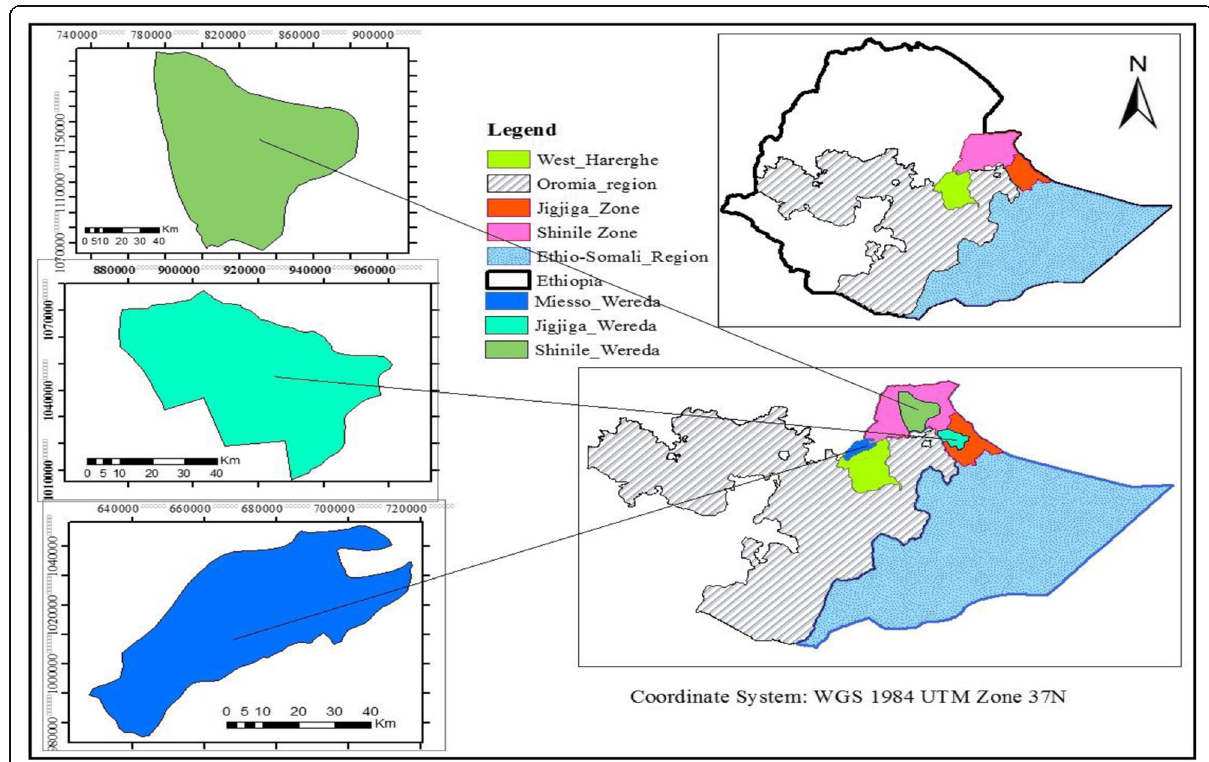
Fig. 1 Geographical location of the study districts; Mieso, Jigjiga, and Shinile in eastern